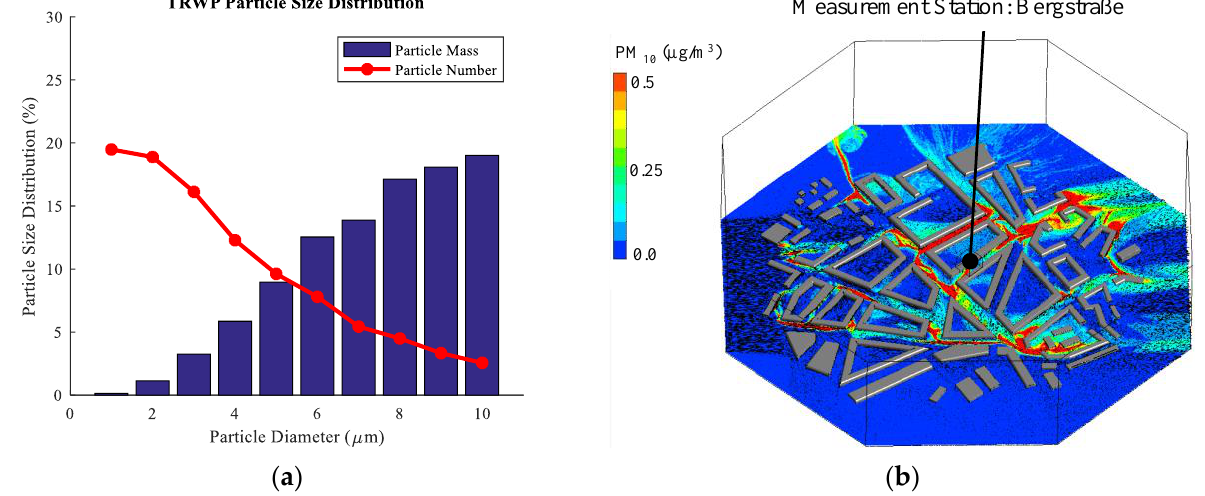
Figure 8. Transfer of a predicted particle emission stream into the flow model considering the particle size distribution: ( a ) particle size distribution of a TRWP sample ( b ) dispersion of TRWP particles within the road canyons of the city model (global wind direction: west/global wind speed 10 km/h).